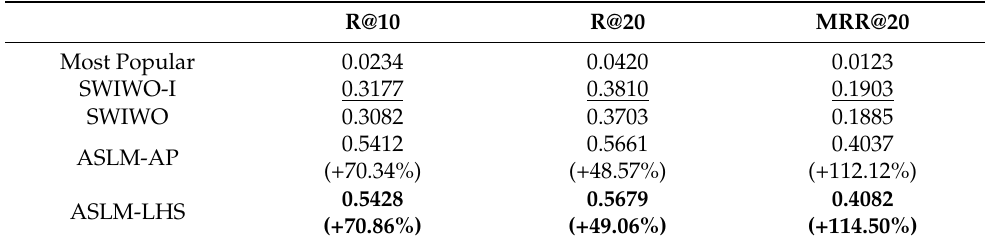
Table 3. Group B: Recall and MRR scores for the ASLM models and the baselines in the Tmall